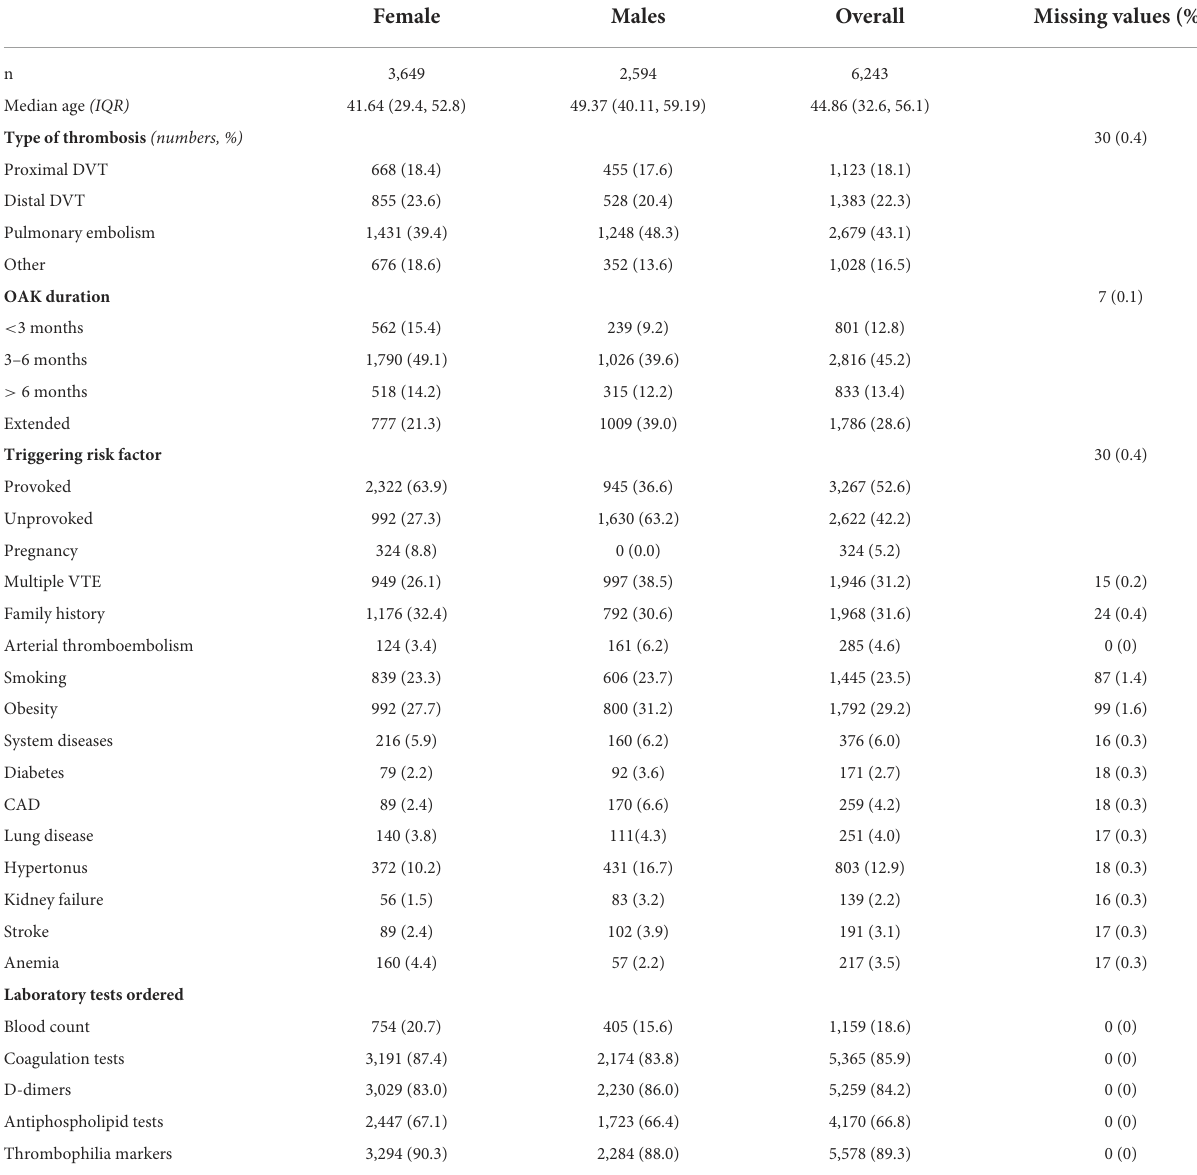
TABLE 2 Patient